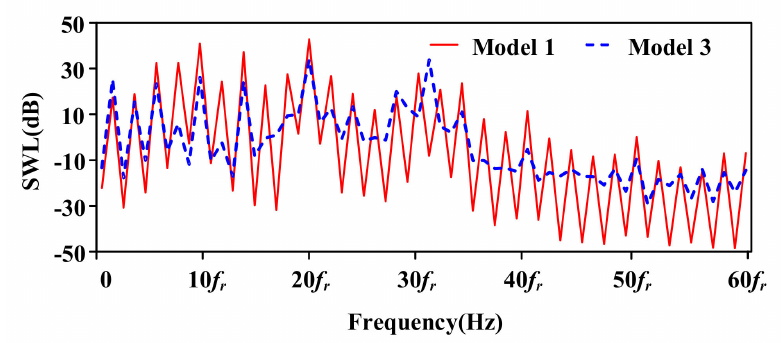
Figure 16. SWL of Mode 1 and Model